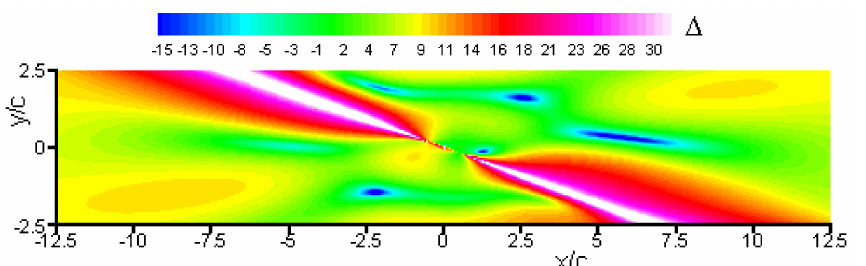
Figure 5. Low frequency ( St = 0.294) noise radiation from the trailing edge of an airfoil set at relatively